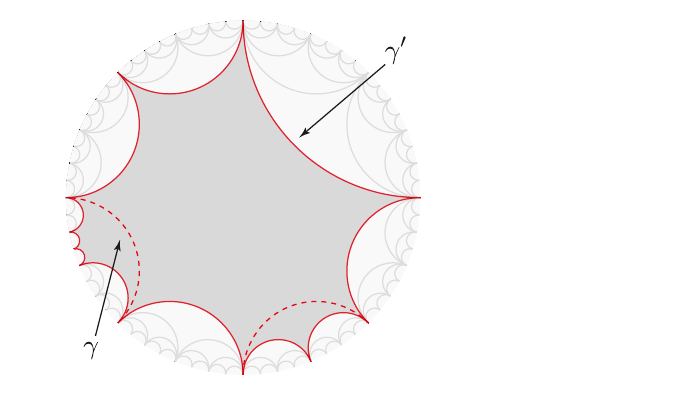
Figure 12 . An example of a pair of cuto(cid:11)s (cid:13) (cid:22) (cid:13) 0 ; here (cid:13) is the original cuto(cid:11) illustrated in the previous (cid:12)gures, and when it di(cid:11)ers from (cid:13) 0 , it is illustrated with a dashed line. (cid:12)nd a cuto(cid:11) (cid:13) 00 in the standard tessellation (cid:28) bigger than (cid:13) and (cid:13) 0 coming from arbitrary 0 tessellations ((cid:12)gure